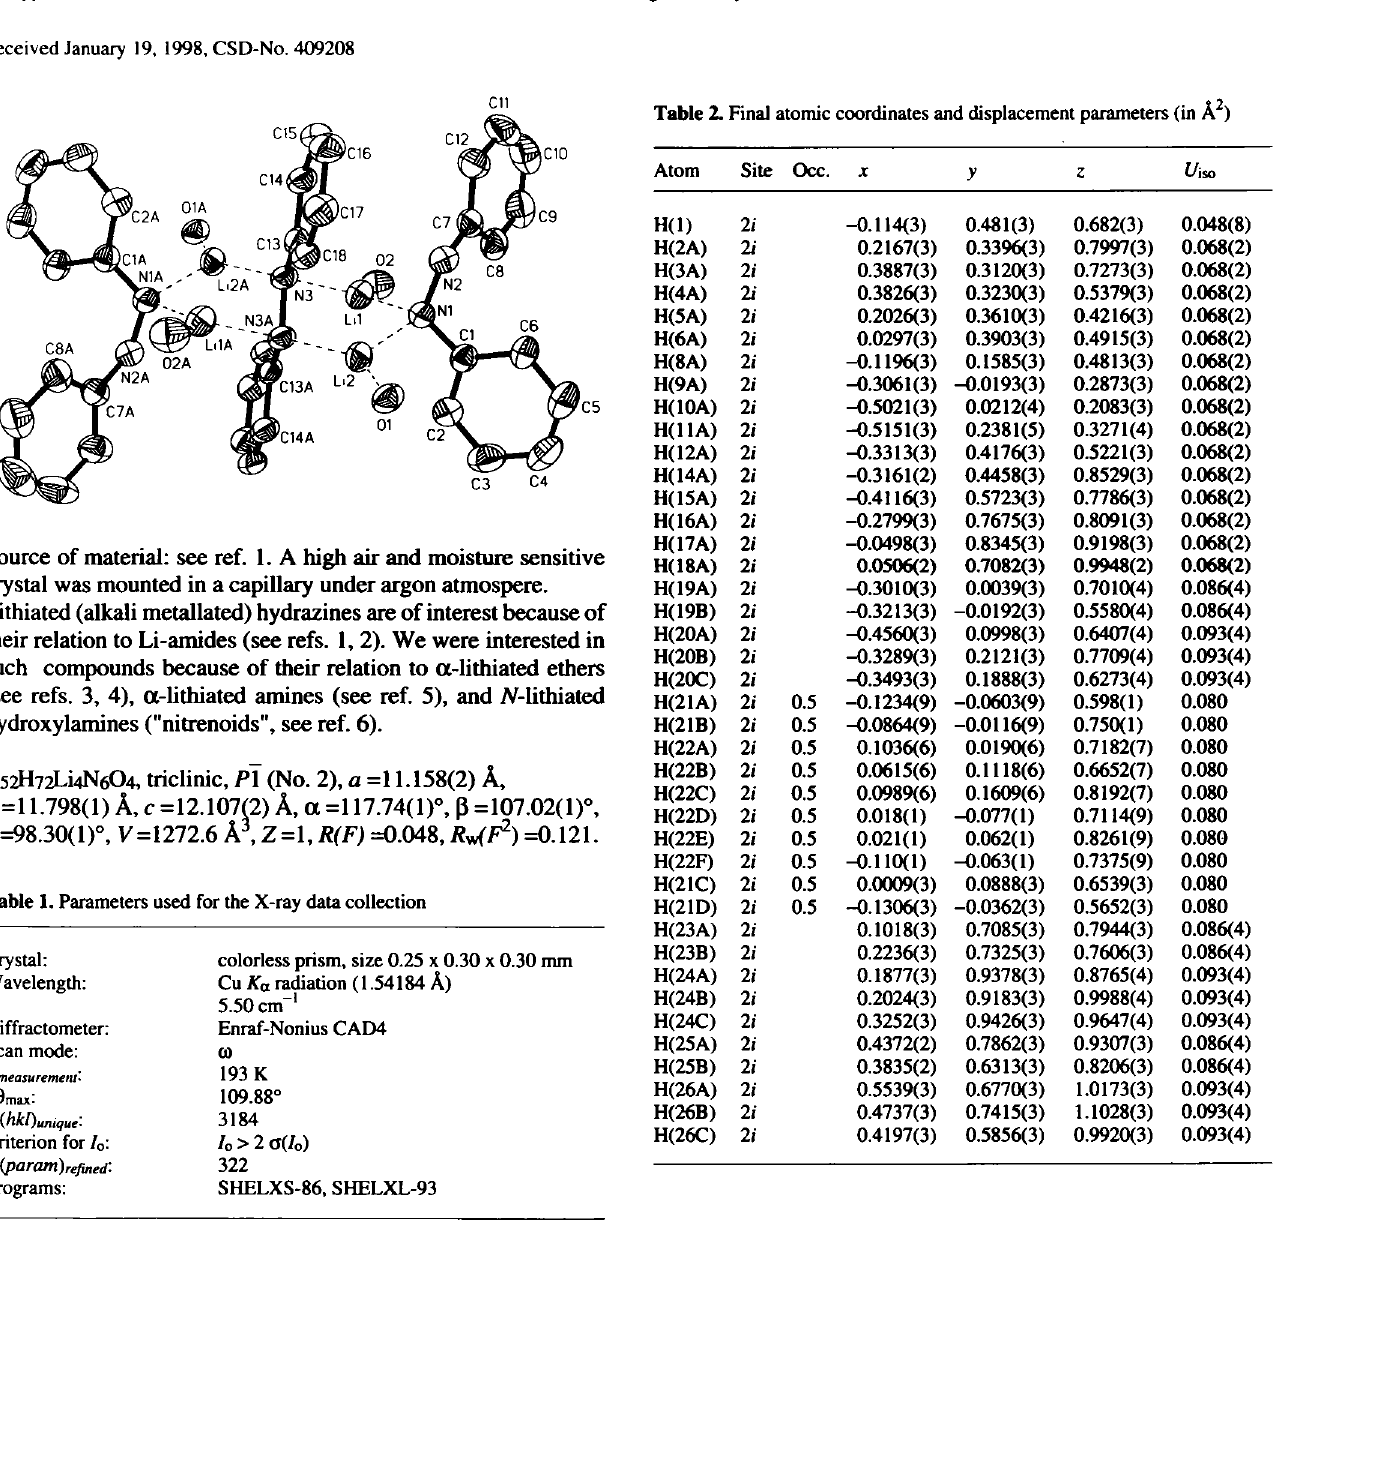
Table 2. Final atomic coordinates and displacement parameters (in Â^)